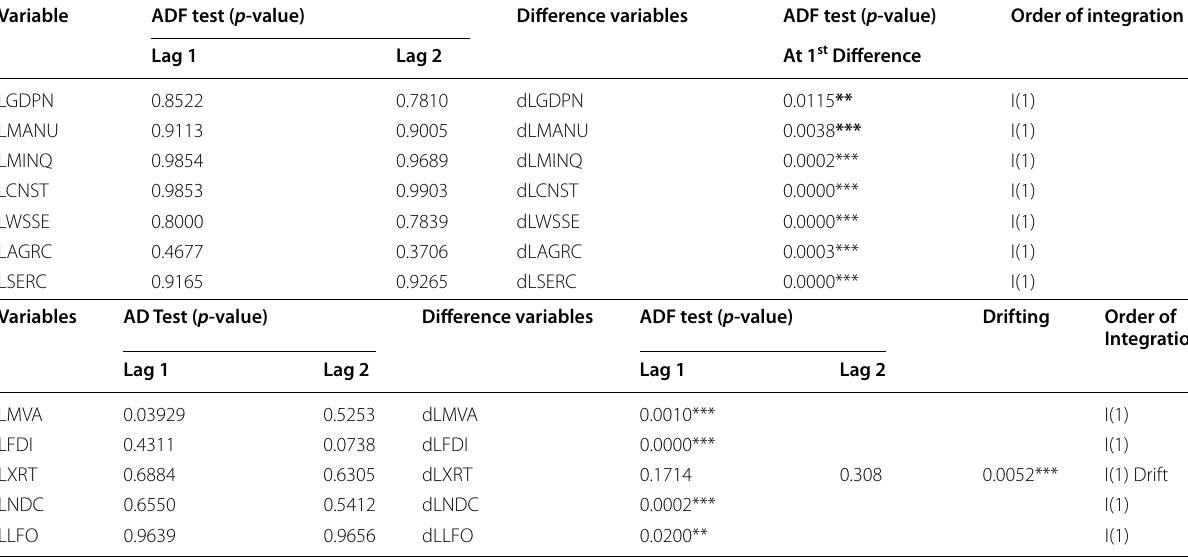
Table 3 Unit root test